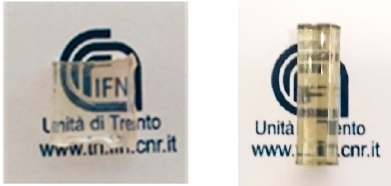
Figure 2. Photo of the as-prepared 90SiO 2 -10SnO 2 :0.5Er 3+ monolithic square with size of 1 × 1 cm 2 and thickness of ≈ 0.3 cm and the cylinder with diameter of 0.5 cm and length of 1.5 cm obtained after the heat treatment at 900 °C for 40 h.